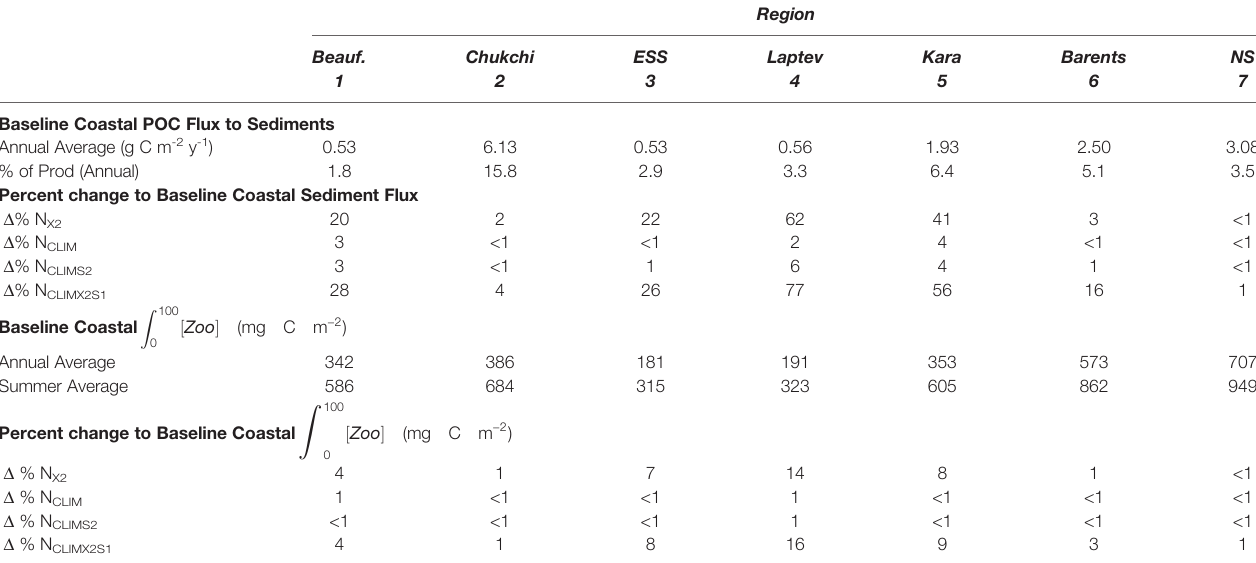
TABLE 3 | Summary of sediment fl ux and zooplankton biomass in the baseline model ( BASE ) and the change seen in the four river nutrient model scenarios (EXP ) during the summer season (June-August) and on an annual basis. Region Beauf. Chukchi ESS Laptev Kara Barents NS